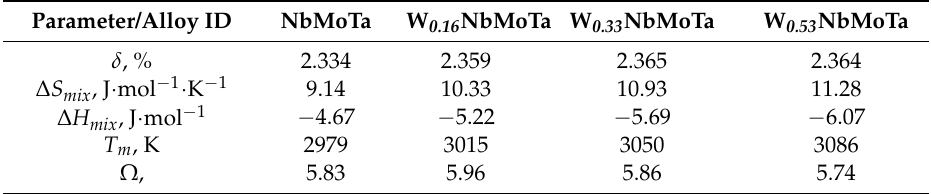
Table 3. The parameters, δ , ∆ S mix , ∆ H mix , T m and Ω for W x NbMoTa high-entropy alloys